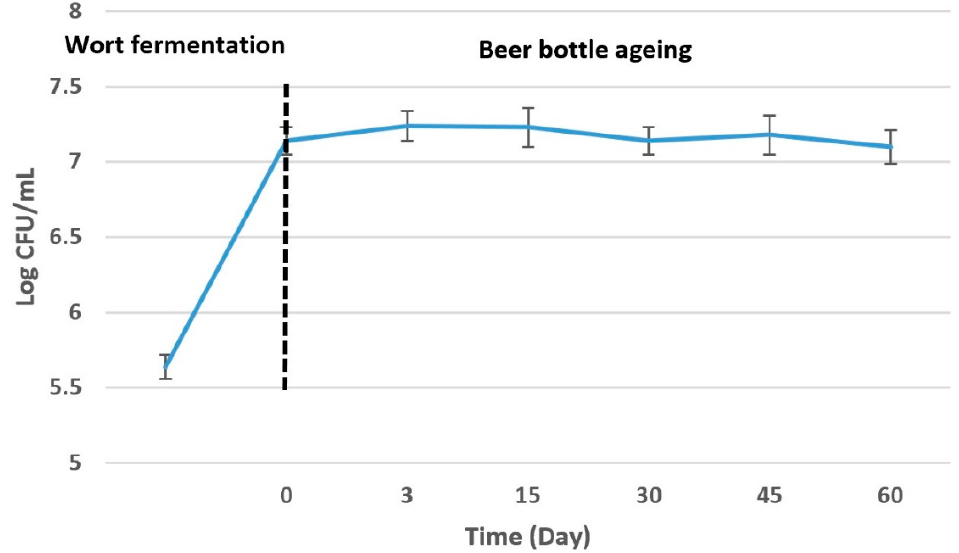
Figure 1. Survival of S. boulardii CNCM I-745 in probiotic beer during storage at 20 °C for 60 days. Wort fermentation was performed for 14 days.